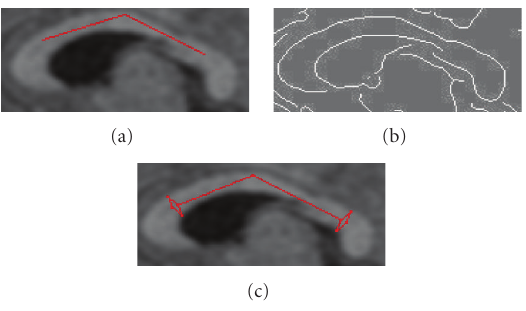
Figure 3: An example of the initialized seed. (a) User-initialized polyline. (b) The edge map. (c) The completed seed contour.